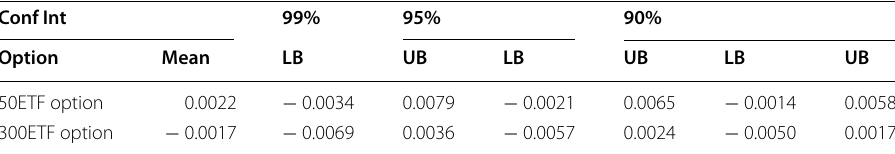
This table displays confidence intervals for the time series of realized option returns with the confidence interval in 99%, 95% and